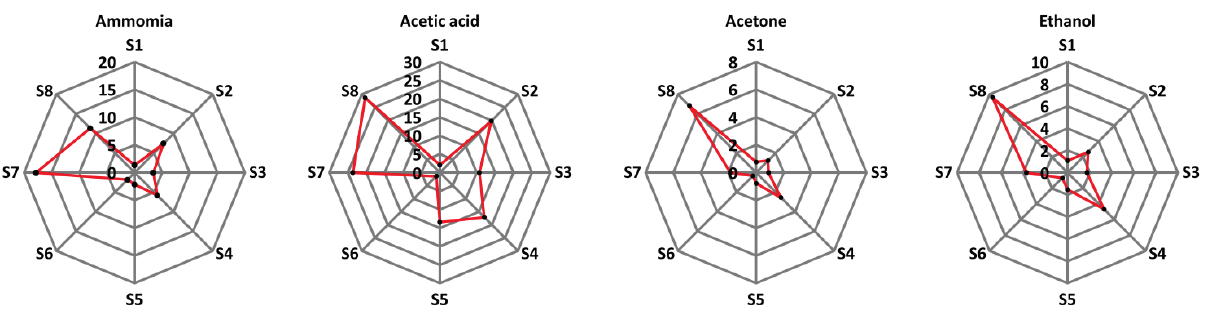
Figure 6. Radar plot of percent sensor response of eight sensor elements (S1–S8) in a static system when exposed to volatiles of ammonia, acetic acid, acetone and ethanol with a concentration of 500